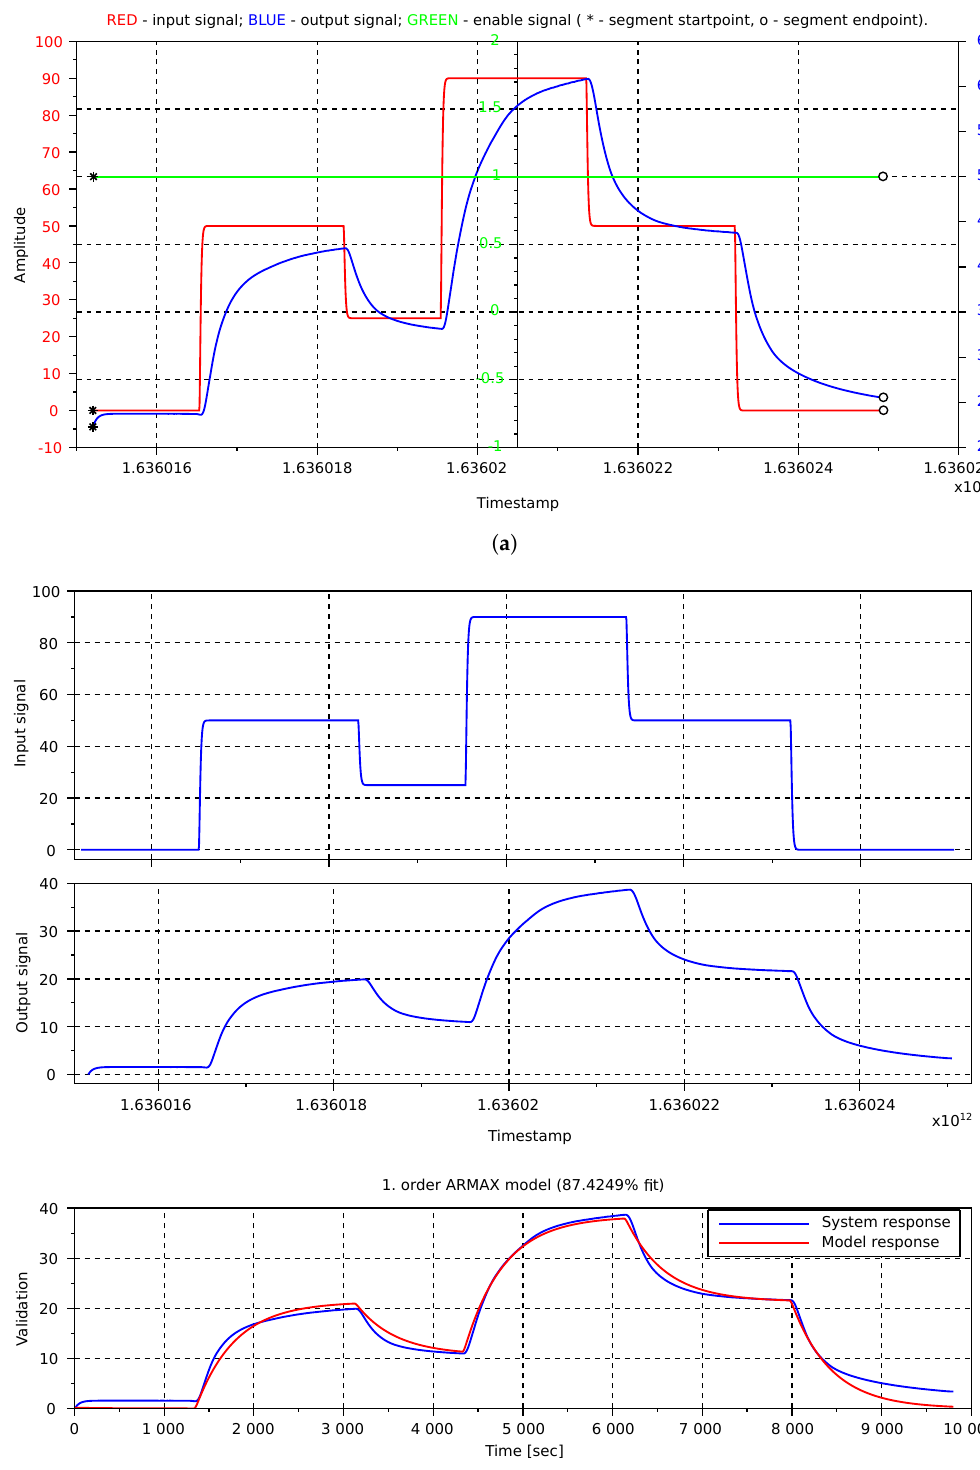
Figure 7. Graphical output from identification of the heating process in room-1 . ( a ) Input, output and enable/disable signals, and their segmentation. ( b ) Input and output data used for identification and model